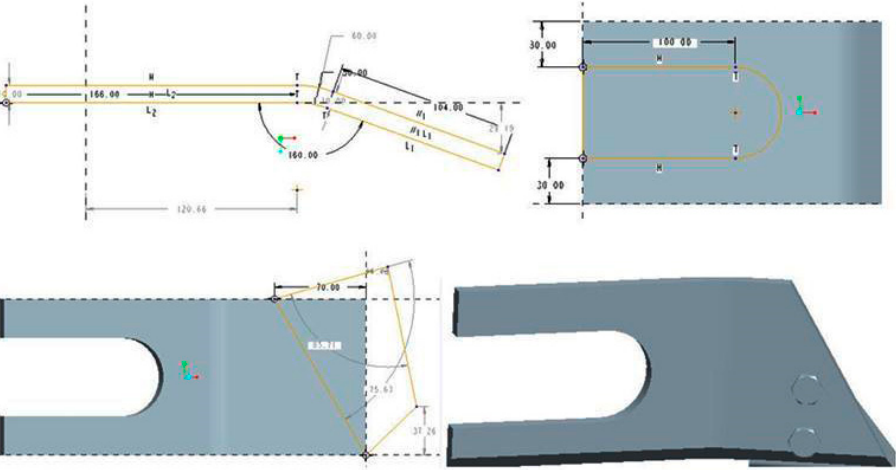
Figure 7. Views and dimensional of Pro/E solid model.